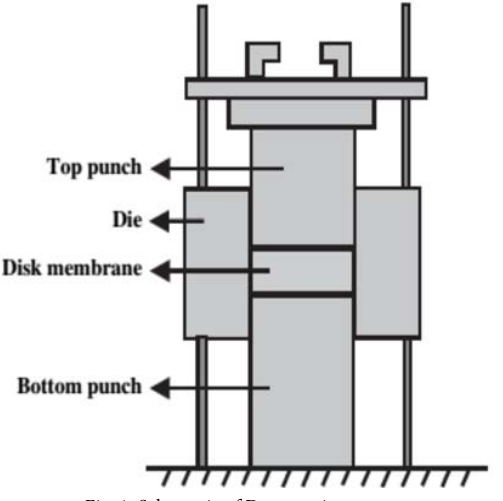
Fig. 1: Schematic of Dry pressing process.